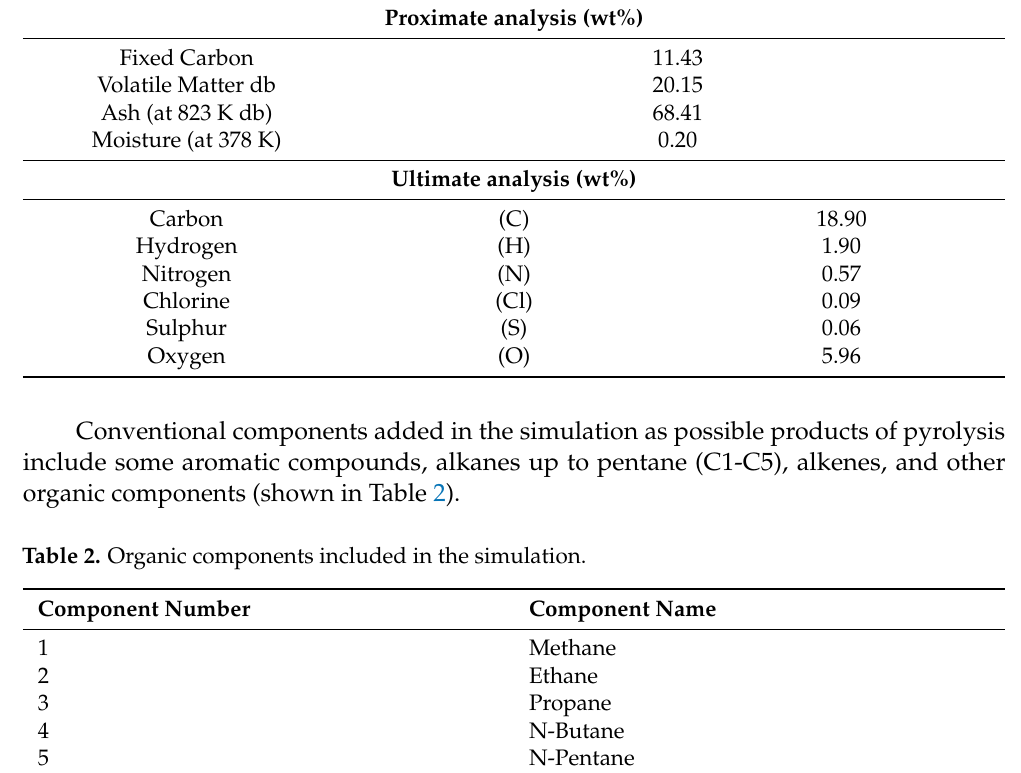
Table 1. Proximate and ultimate analyses of PCBs.